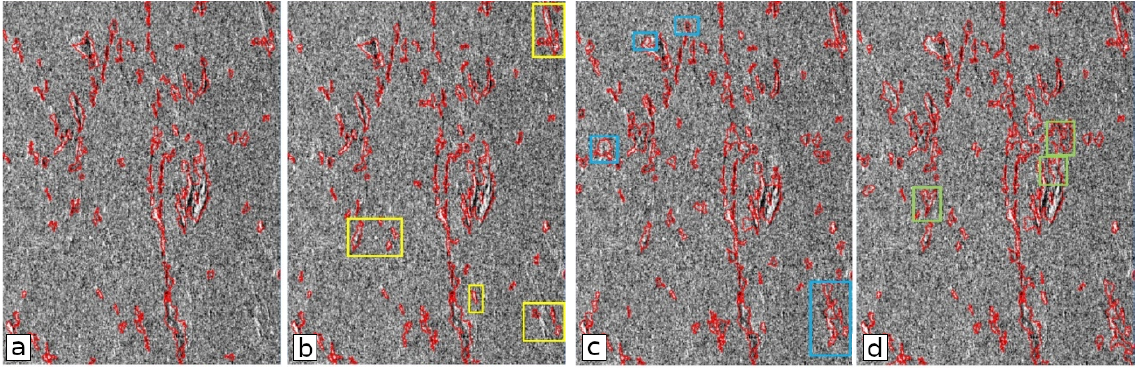
Figure 11. Comparison of supervised classification results, including ( a ) Support Vector Machine (SVM) (Radial Basis Function (RBF)); ( b ) SVM (linear); ( c ) Nearest Neighbor (NN); and ( d ) Random Forest (RF). Upon visual comparison, it is firstly observed that SVM (RBF) extracted fewer potential landslide sites among the four results. SVM (linear) outperforms SVM (RBF) by extracting more potential landslide sites, outlined in yellow boxes. Compared with SVM (linear), additional landslides extracted by NN are outlined in blue boxes. Landslides detected by RF but not NN are outlined in green boxes in (d). Although it is found that there are a few red polygons detected by NN but not by RF, it is realized that most of them are noise clusters. Therefore, it is determined that the Random Forest is superior to other methods and is selected as the image classifier in the processing